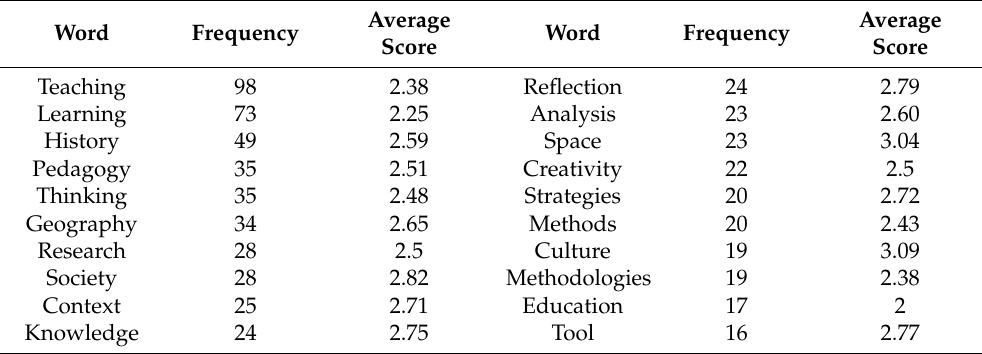
Table 1. Words associated with the didactics of the social